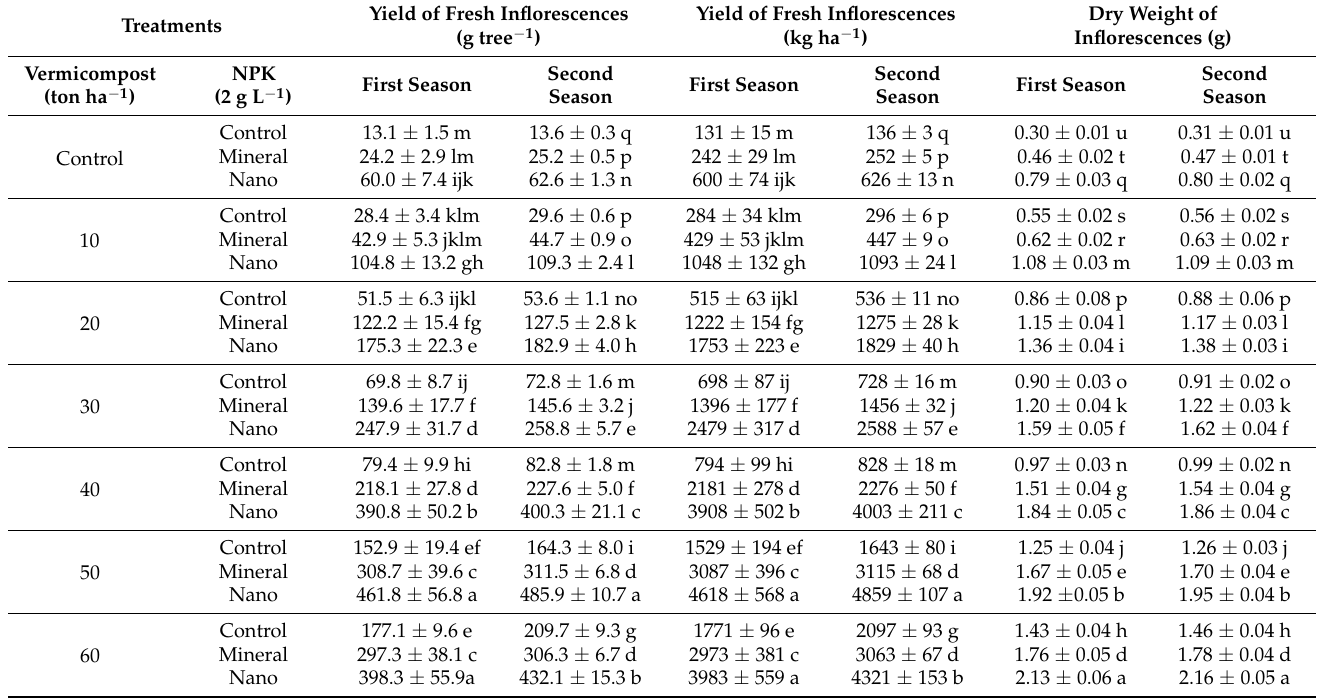
Table 5. The influence of combined treatments of vermicompost and NPK fertilization on the mean values of yield of fresh inflorescences (g tree − 1 ), yield of fresh inflorescences (kg ha − 1 ), and dry weight of inflorescences (g) of Moringa oleifera trees in the first and second seasons. Yield of Fresh Inflorescences Yield of Fresh Inflorescences Dry Weight of Treatments (g tree − 1 ) (kg ha − 1 ) Inflorescences